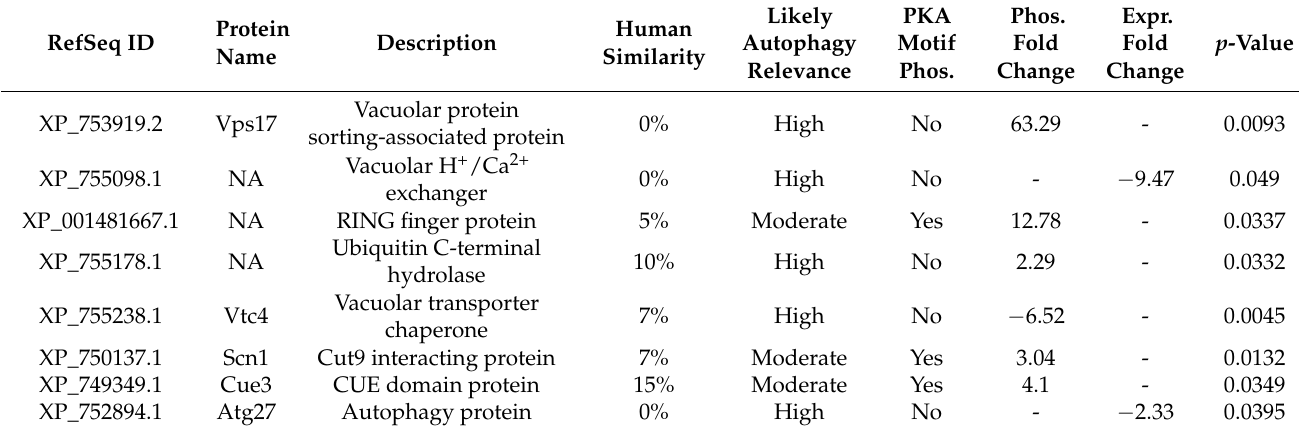
Table 3. Prioritized PKA-regulated autophagy-associated proteins.